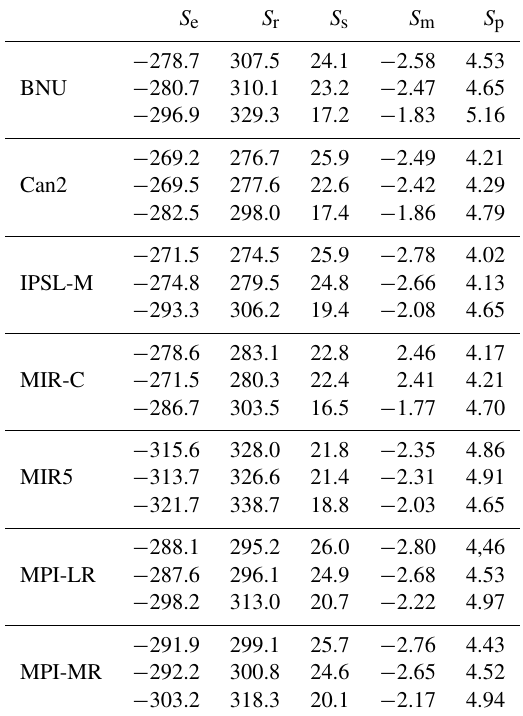
Table 9. The 20-year annual mean material entropy production as- sociated with the hydrological cycle. Each component denotes a dif- ferent process: (from left to right) evaporation, rainfall precipitation, snowfall precipitation, snow melting at the ground and the potential energy of the droplet. For each model, the first row denotes the es- timates from piC, the second row from hist and the third row from RCP8.5 (values: mWm − 2 K − 1 ).